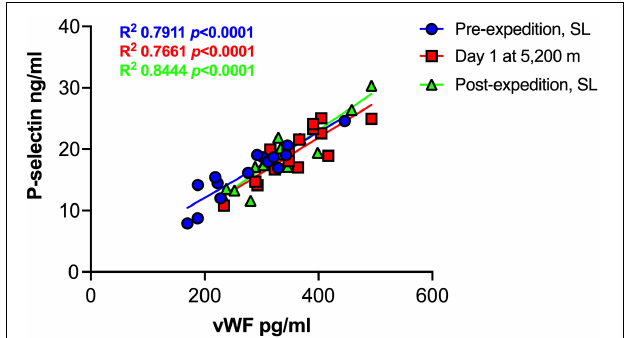
FIGURE 3 | Strong positive correlation between Plasma P-selection and von Willebrand Factor (vWF) at sea level and during high altitude induced hypoxia. Plasma vWF and P-selectin assessed by Luminex immunoassay ( n = 16). SL; sea level.